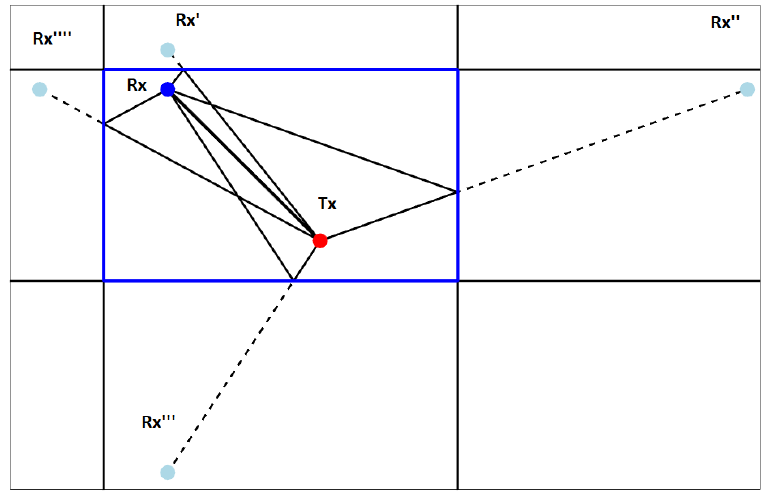
Figure 11. Example of possible “virtual” positions of a sensor due to reflections (2D).